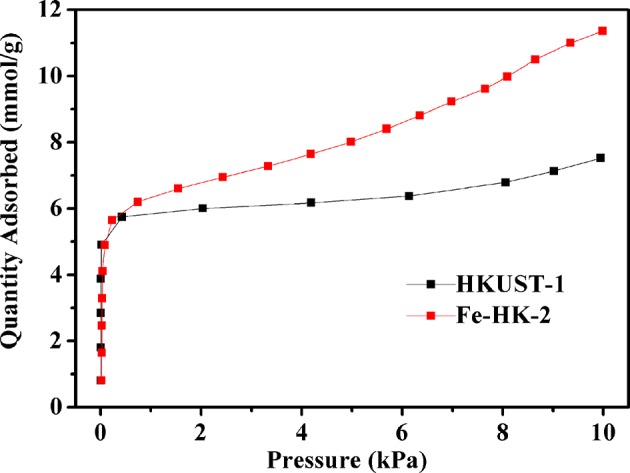
Adsorption isotherms of benzene on HKUST-1 and Fe-HK-2 at 298 K.